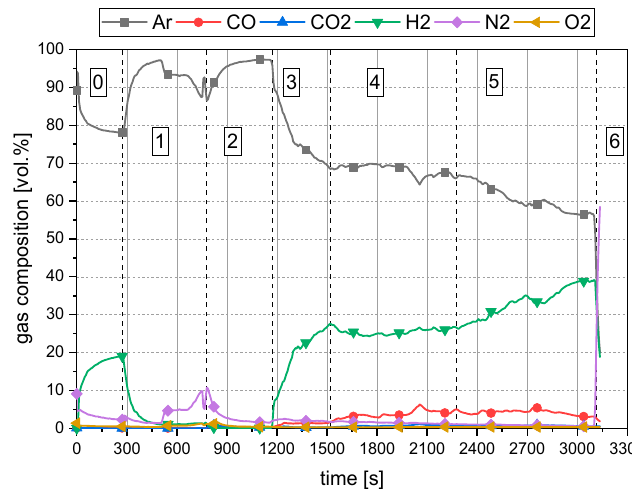
Figure 7. Representation of the performed process steps B50/C1.04. The left photo in Figure 8 shows a view of the crucible (1) with the protective refractory ring (2) and with the charged ore batch (3) before the trial B50/C1.4. After the experiment, the right photo presents the crucible with the solidified molten material (4). It is evident that the melt has formed a more or less flat surface. The reason is that the crucible’s sidewalls were melted down. The total volume of the molten material is composed of the molten and reduced iron ore, the ignition pin, and the melted sidewalls of the crucible. A small amount of non-melted or reduced ore remains in the center on the surface. This discharged material originated from the HGE during the dismantling of the reactor. This amount is subtracted from the initially inserted ore mass (Table 3). Without this subtraction, the calculation of the reduction degree would result in excessively high values.